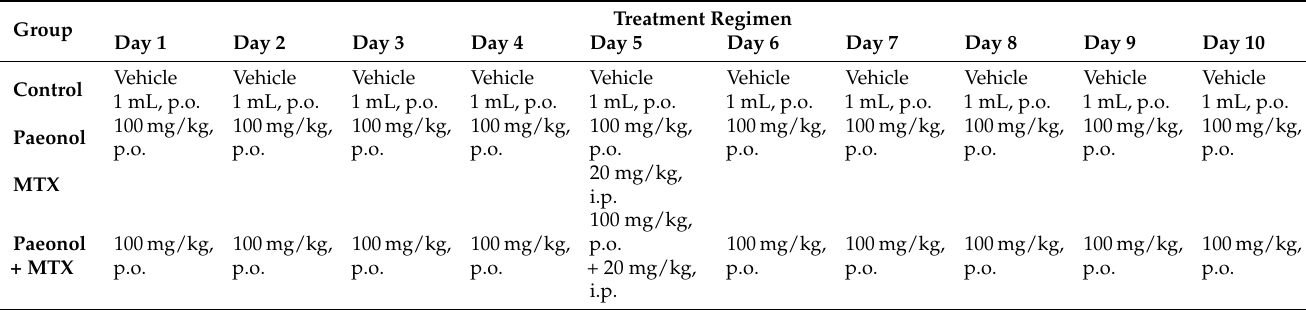
Table 1. Timeline schedule of the treatment regimen. MTX: